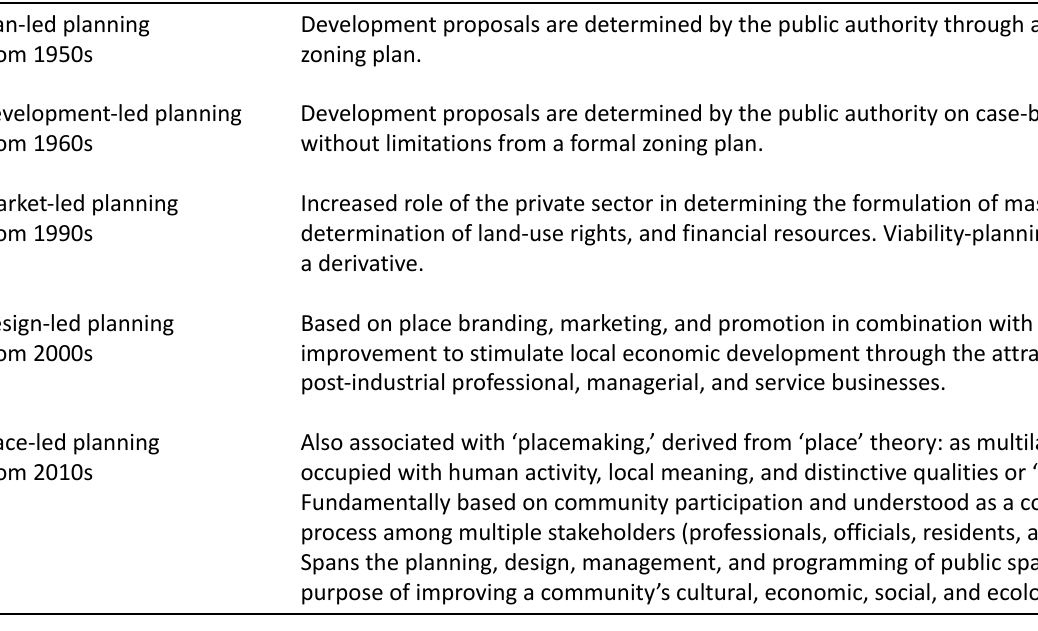
Table 1. Phases of urban planning leading to place-based approaches. Plan-led